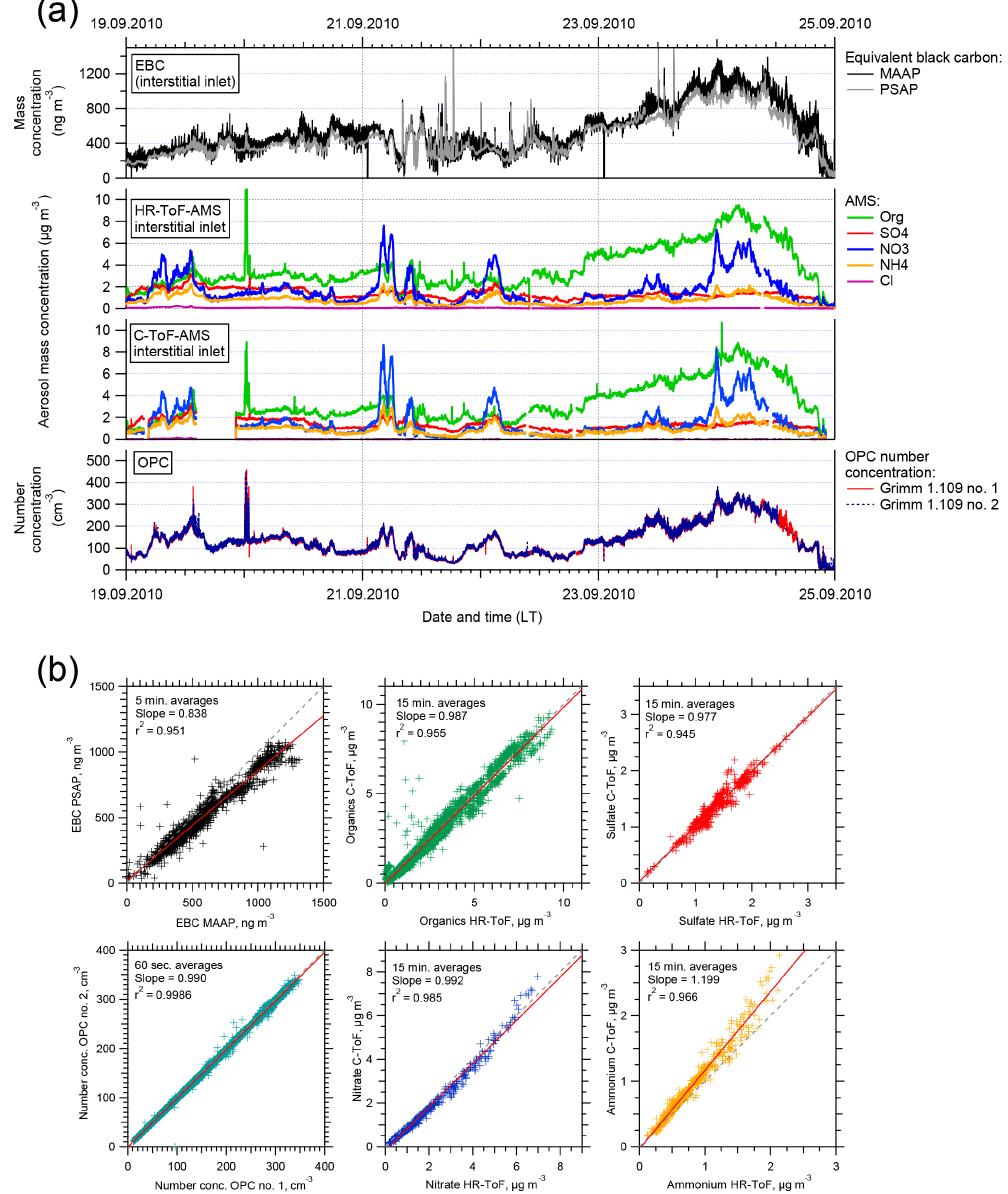
Figure 2. (a) Time series of aerosol mass concentrations (EBC, organics, sulfate, nitrate, ammonium, and chloride) and number concentration ( d p > 250nm) measured during 6 cloud-free days when all instruments sampled through the interstitial inlet. (b) Correlation plots of the compared data sets along with slopes and regression coefficients. The respective averaging times are